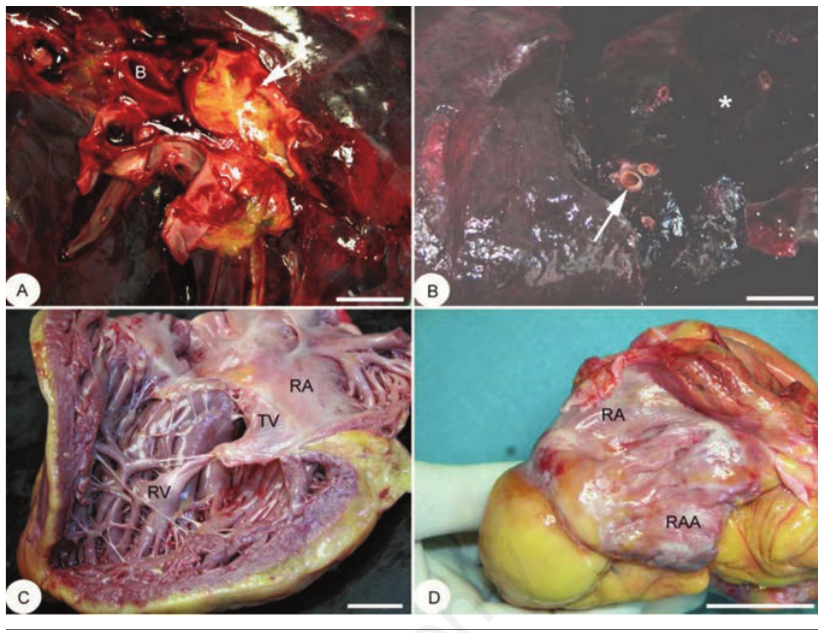
Figure 2. Autopsy images. A) The right lung hilus with an exceedingly thick pulmonary artery (arrow) which shows an aortic-like appearance. B) On cut section, the lung parenchy- ma (asterisk) is extremely hemorrhagic and displays rigid and thick peripheral pulmonary artery branches (arrow). C) The right ventricle is highly hypertrophic. D) The right-atrial appendage had undergone marked dilation and become part of the main right atrial cham- ber. Abbreviations: B, bronchus; RA, right atrium; RAA, right-atrial appendage; RV, right ventricle; TV, tricuspid valve. Size of bars A) and B): 3 cm, C) and D): 2 cm.